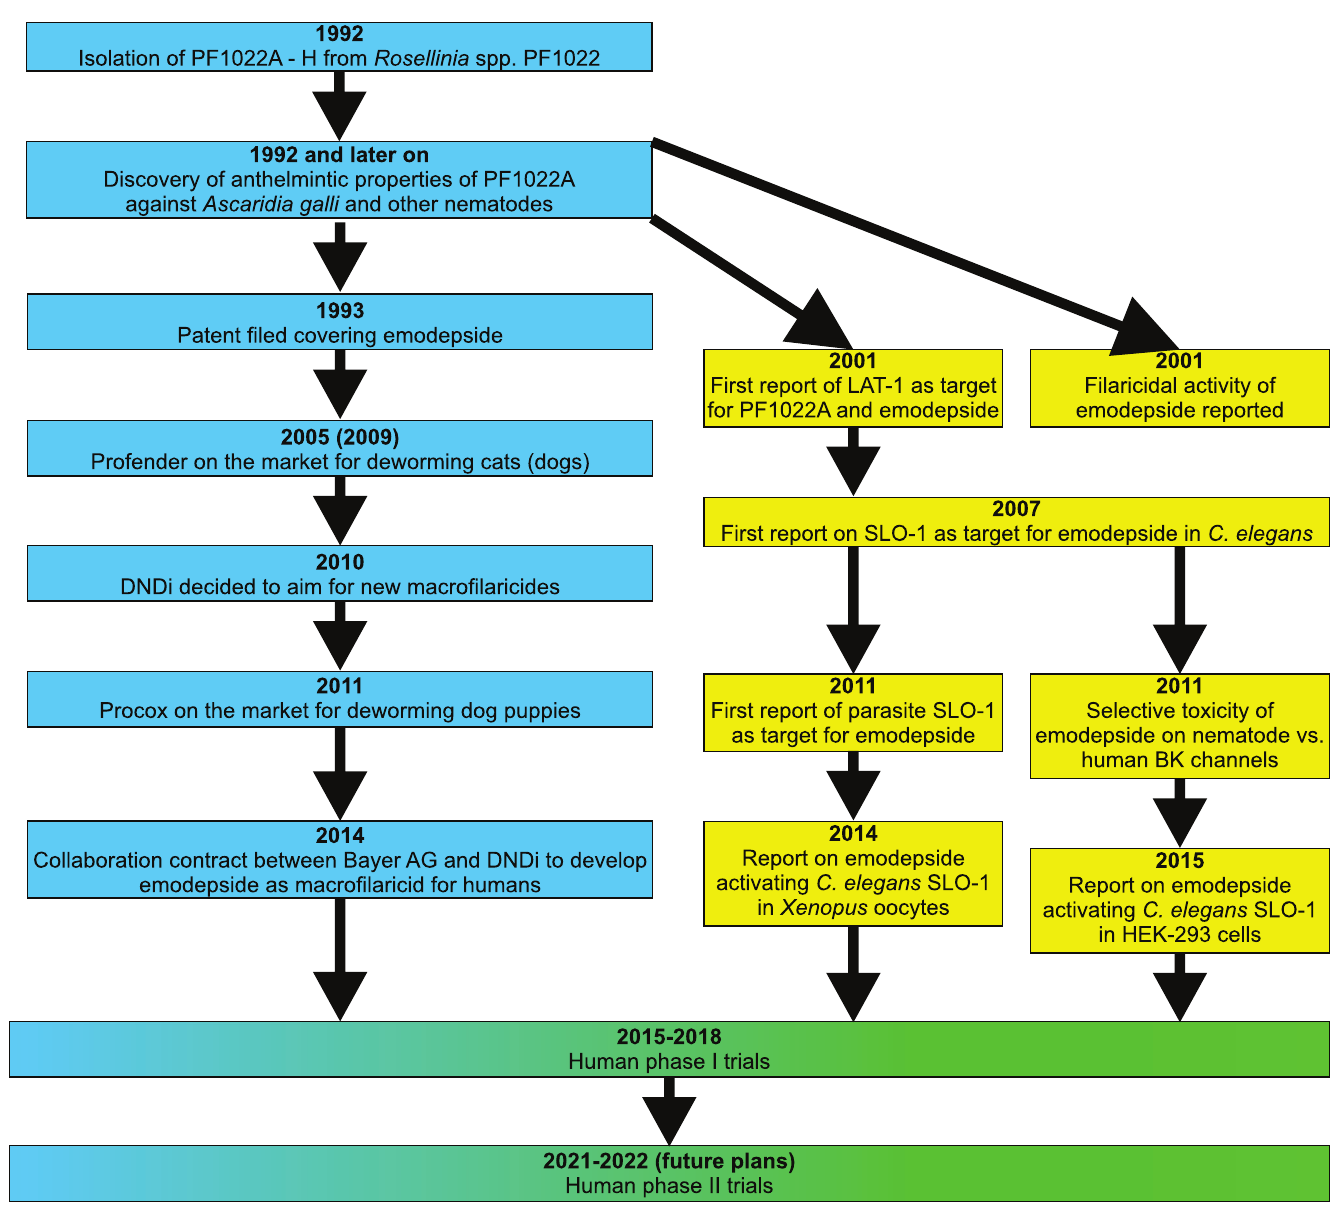
Fig 2. Flow chart summarizing the most important achievements from the isolation of PF1022A to recent and future human trials. Milestones with pharmaceutical industry in lead are shown in blue, and milestones achieved with academia in lead are shown in yellow. BK, Big Potassium; DNDi, Drugs for Neglected Diseases initiative; LAT-1, latrophilin-like